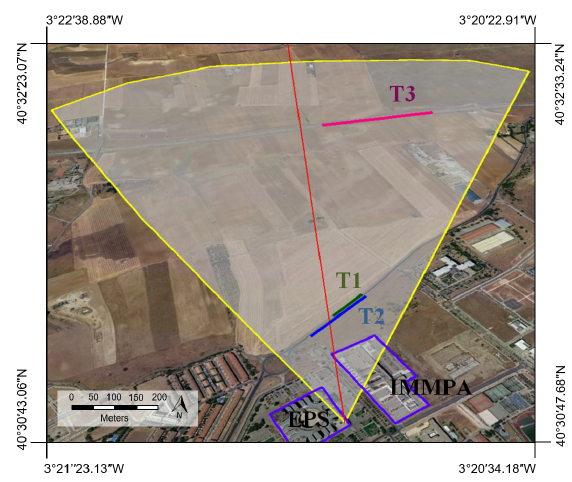
Figure 20. Targets trajectories in the coverage sector (white). The Polytechnic School of University of Alcalá (EPS, Escuela Politécnica Superior ) and a big building made of aluminum (IMMPA, Instituto de Medicina Molecular Príncipe de Asturias ) are marked in purple.